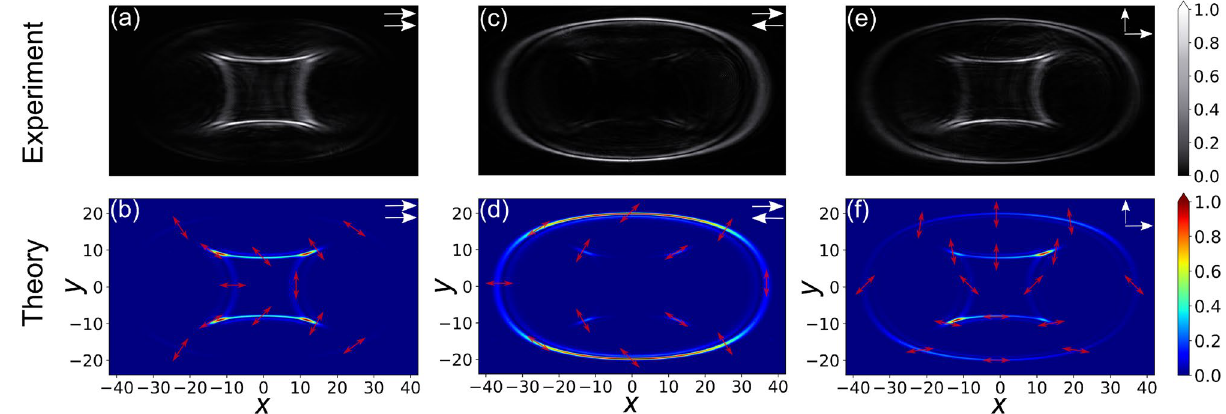
Figure 2. Experimentally observed (upper row) and theoretically calculated (lower row) non-circular conical diffraction patterns for the cases of parallel, ( a ) + ( b ), antiparallel, ( c ) + ( d ), and crossed biaxial crystals, ( e ) 1.25 and + ( f ). The magnifications between the planes FIP1 and FIP2 provided by the crossed CL are M x = 0.325 . The coordinates x M y M y ρ sin ϕ in the theoretical plots are proportional M x ρ cos ϕ and y = = − = − to the linear dimensions on the CCD camera. The red arrows give the local linear polarization direction. The intensity scales are shown on the